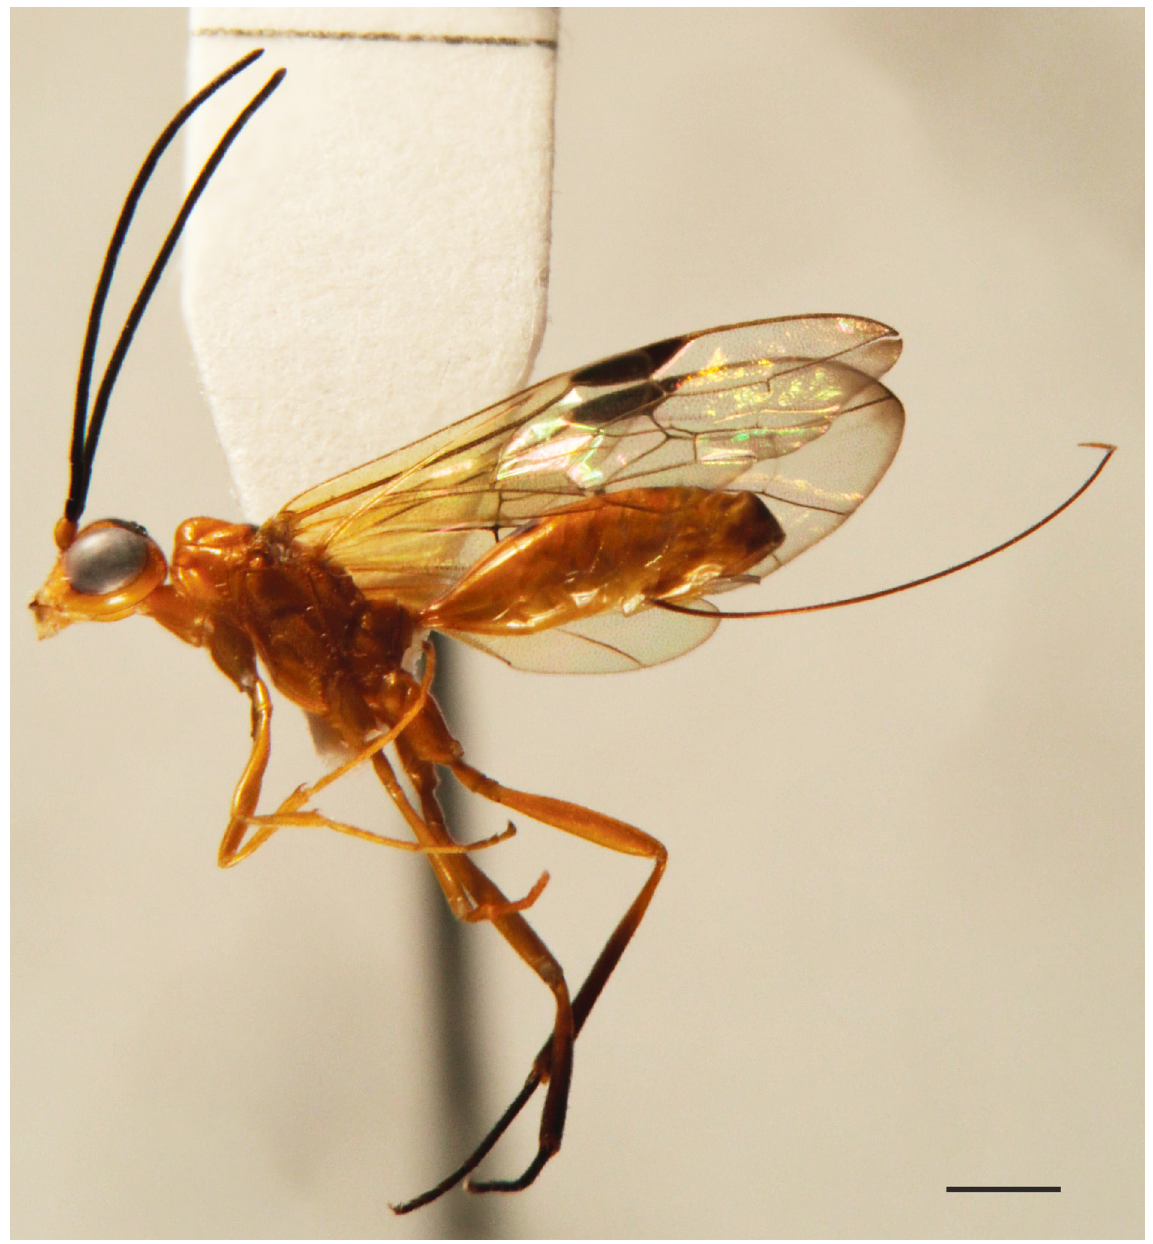
Fig. 3. Pristaulacus elveni sp. nov., holotype, ♀ (MNHN), lateral habitus. Scale bar = 1.0